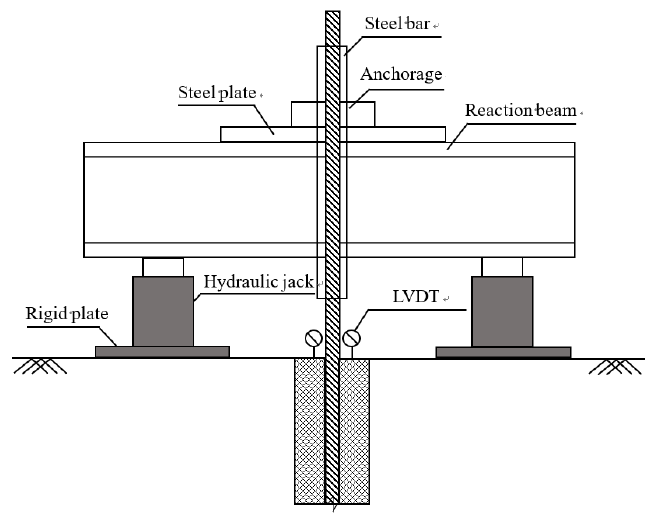
Figure 4. Schematic diagram of pulling test.